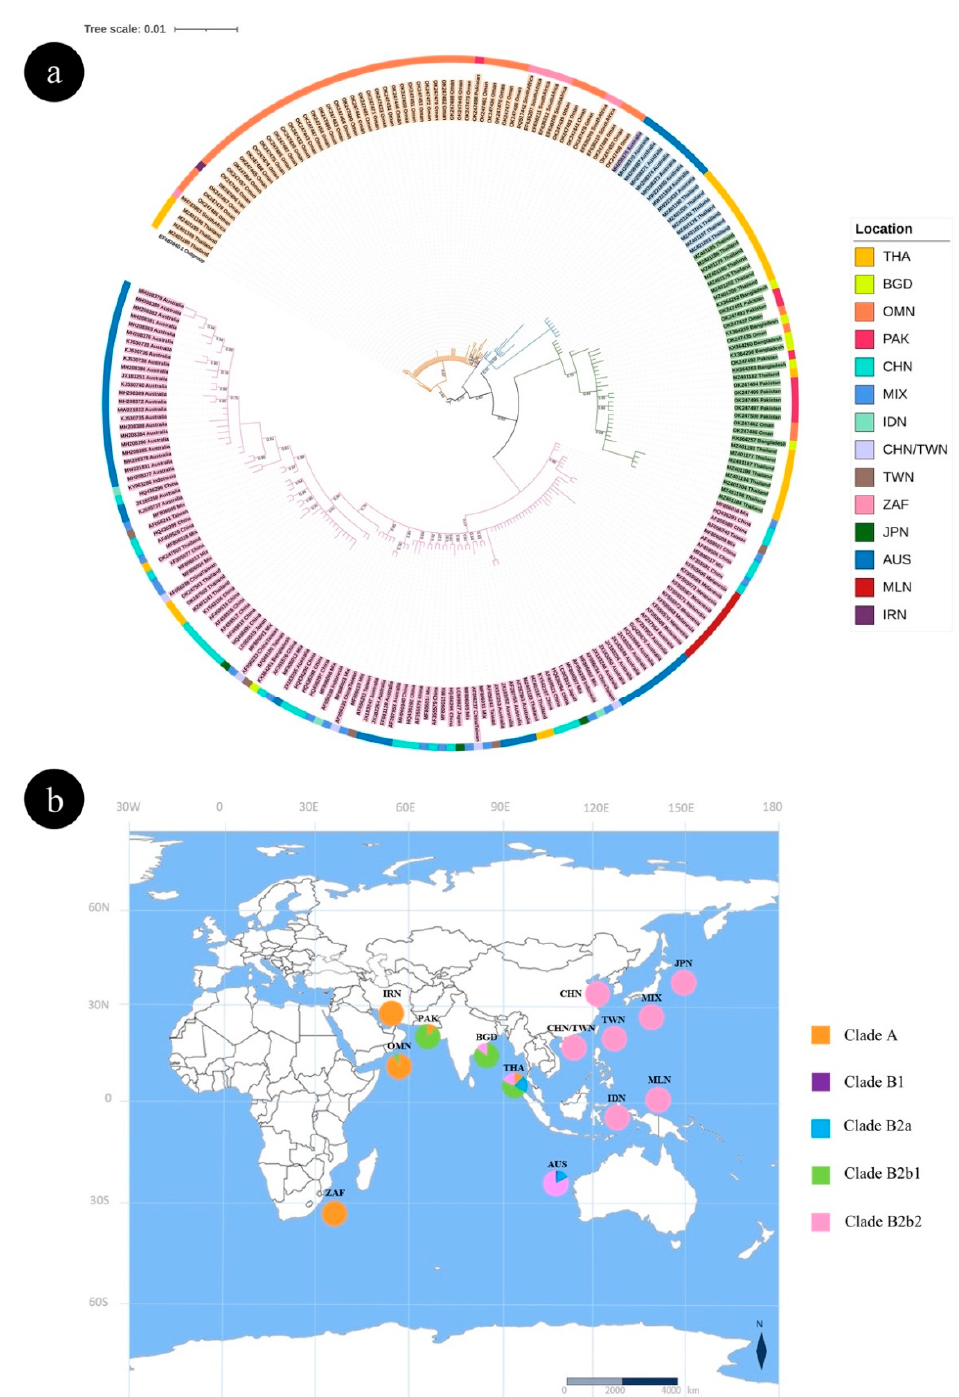
Figure 5. Phylogenetic tree and geographic distribution of T. aduncus through mtDNA control region analysis. ( a ) Phylogenetic tree based on 256 bp from 232 sequences of T. aduncus, illustrating five clades by color. The number label on the branches is the posterior probability (PP) of the supporting branch. All branches have a PP value greater than or equal to 0.50, and the branches without number labeling indicate a PP value greater than 0.99. The peripheral circle colors indicate location: Thailand (THA), Bangladesh (BGD), Oman (OMN), Pakistan (PAK), China (CHN), Taiwan and Japan (MIX), Indonesia (IDN), China and Taiwan (CHN/TWN), Taiwan (TWN), South Africa (ZAF), Japan (JPN), Australia (AUS), Melanesia (MLN), and Iran (IRN). ( b ) The geographic distribution of T. aduncus by clades based on the phylogenetic tree on the global scale.